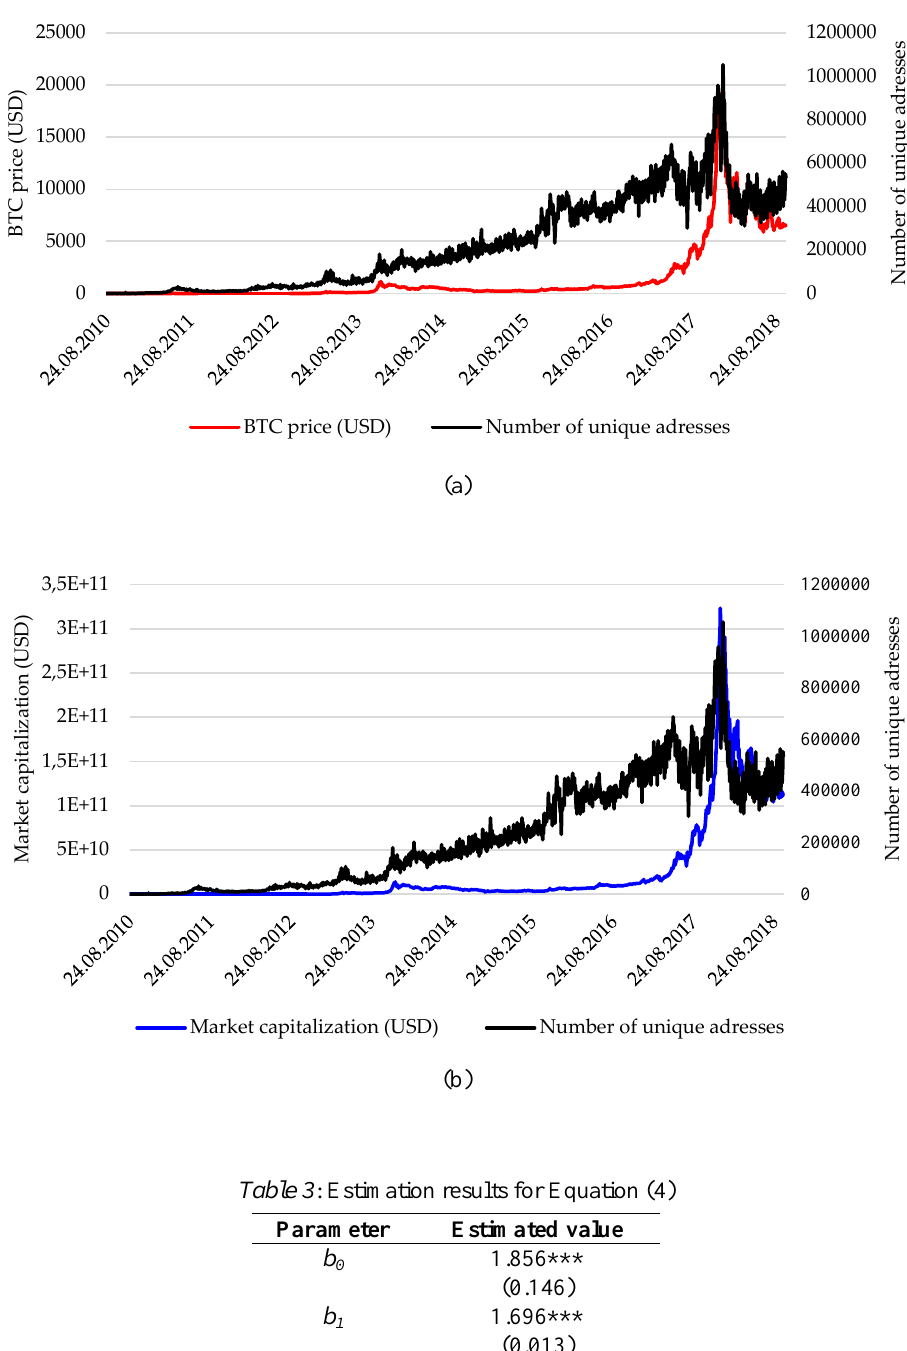
Figure 3 : (a) Bitcoin average price (USD) vs. number of unique Bitcoin addresses used per day (b) Bitcoin market capitalization (USD) vs. number of unique addresses